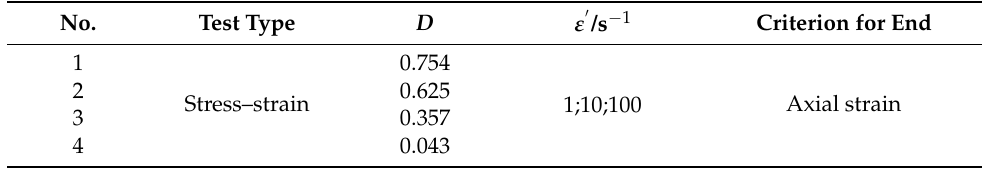
Table 6. Experimental scheme of dynamic compression test.